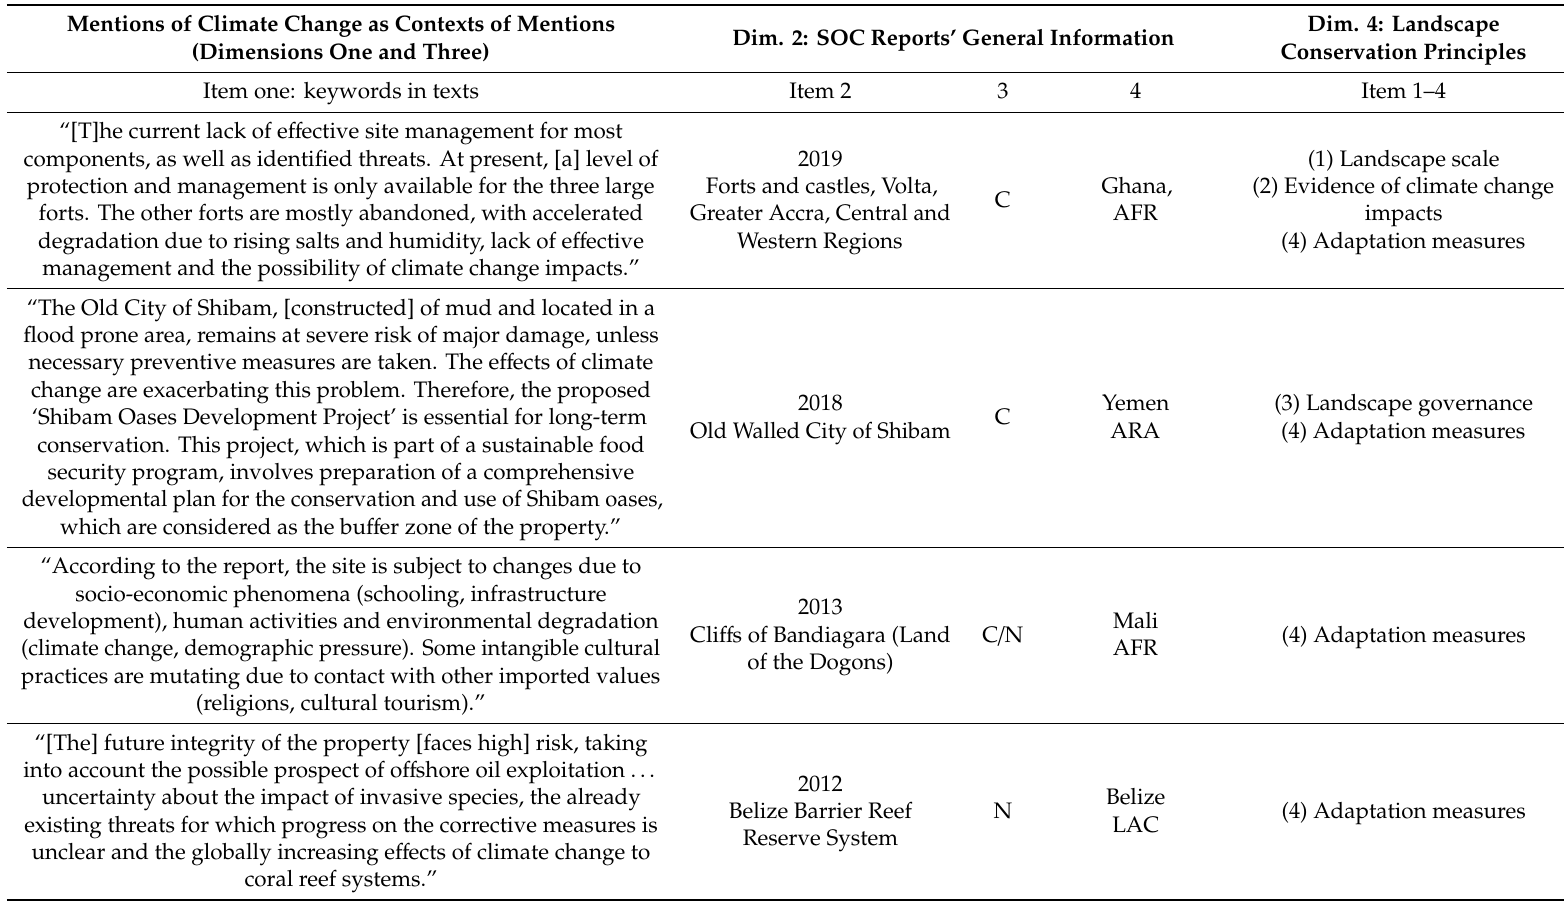
Table 2. Summary of main findings per WH